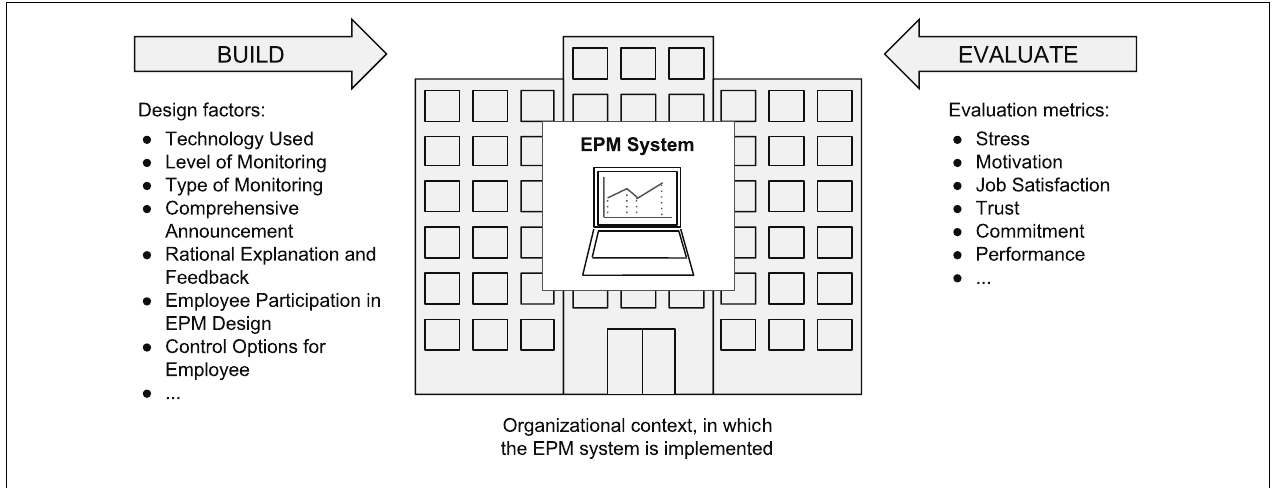
FIGURE 4 | EPM design science